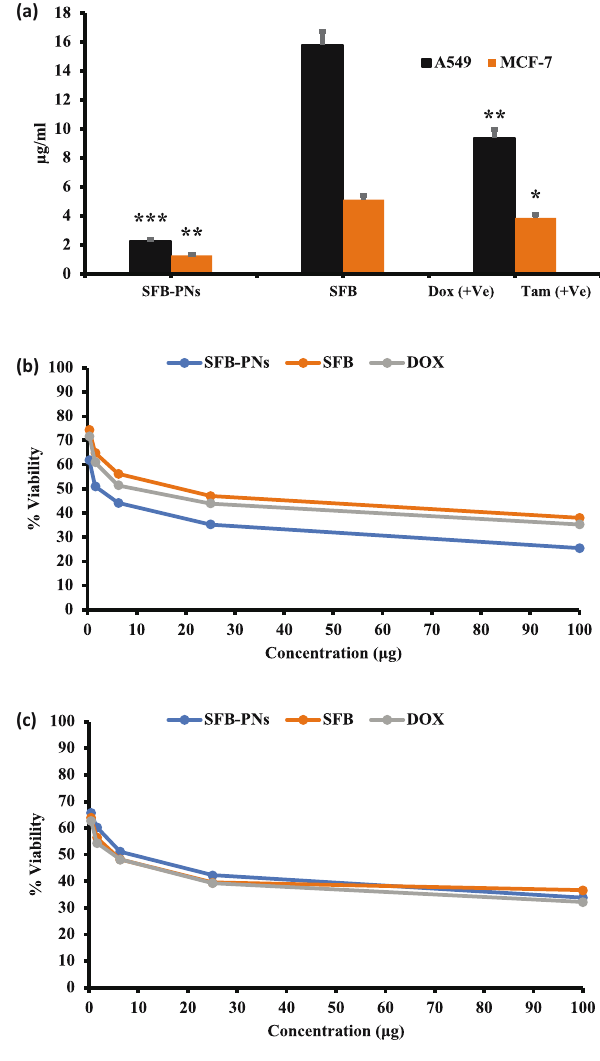
Figure 4: Cytotoxicity - IC 50 of A549 and MCF - 7 cell lines treated with SFB - NPs. Cells were treated for 48h with increasing concentrations of anticancer drugs. ( a ) IC 50 of concurrent drugs for both cell lines. Cells were treated for 48h with increasing concentrations of SFB, SFB - PNs, DOX, and Tam on ( b ) cell viability dose response curve of A549 cell lines, and ( c ) cell viability dose response curve of MCF - 7 cancer cell lines, respectively. * p ≤ 0.05, ** p ≤ 0.01, or *** p ≤ 0.001 denote statistically signi fi cant di ff erences compared to control